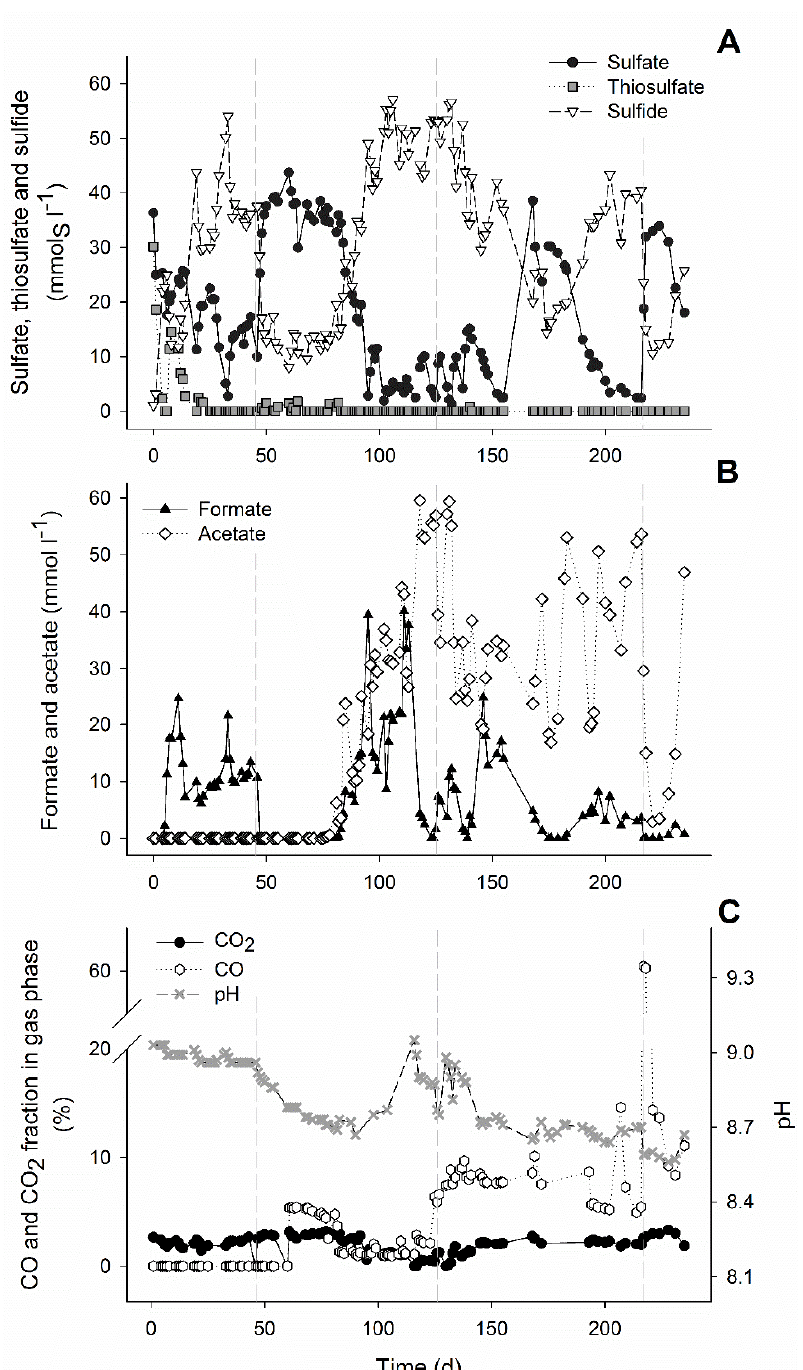
Figure 1. Concentrations of sulfate, thiosulfate and sulfide ( A ), formate and acetate ( B ), and pH and fractions of CO and CO 2 in the gas phase of the bioreactor during the bioreactor experiment ( C ), Vertical dashed lines represent the start of CO experiments: 5% CO (1st), 15% CO (2nd), and 60% CO spike (3rd).